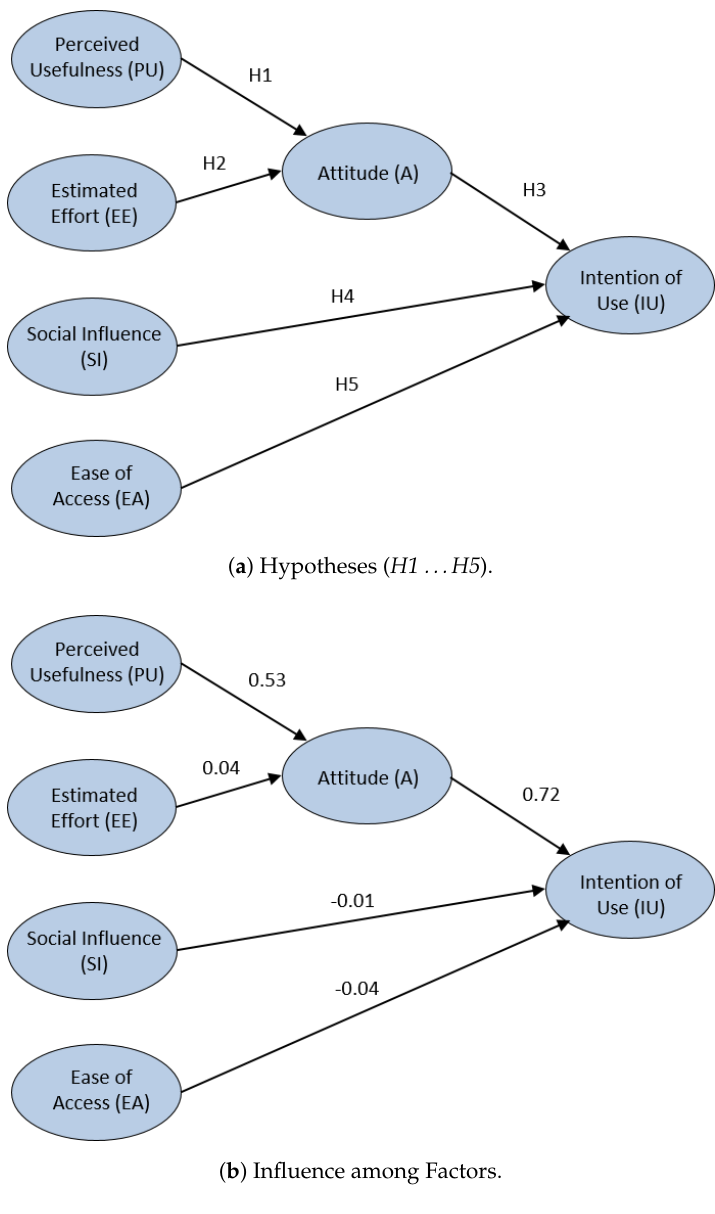
Figure 12. SEM for the ViRe-Lab with the UTAUT